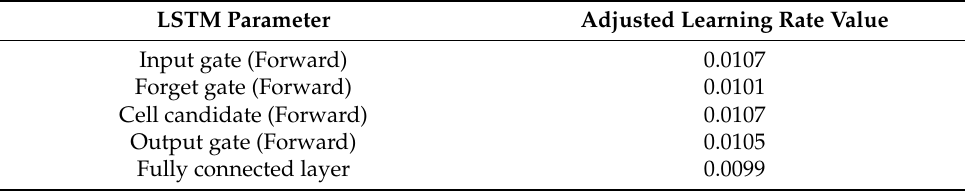
Table 11. The new learning rate values of LSTM parameters (engine dataset).